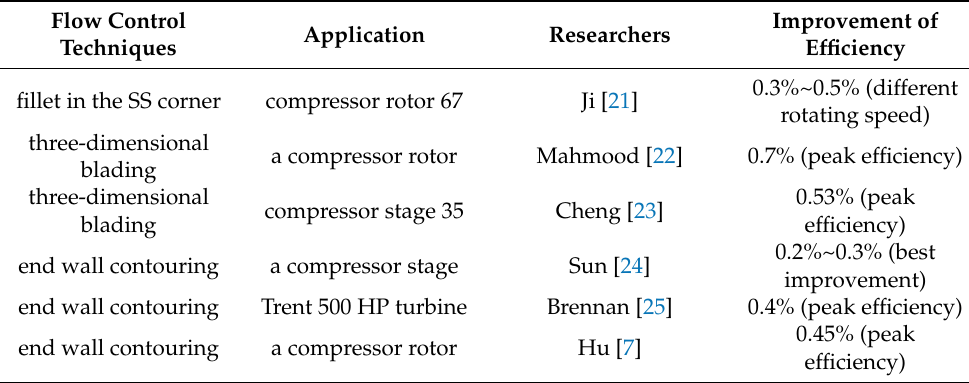
Table 1. Effect of different flow control techniques on turbomachineries.